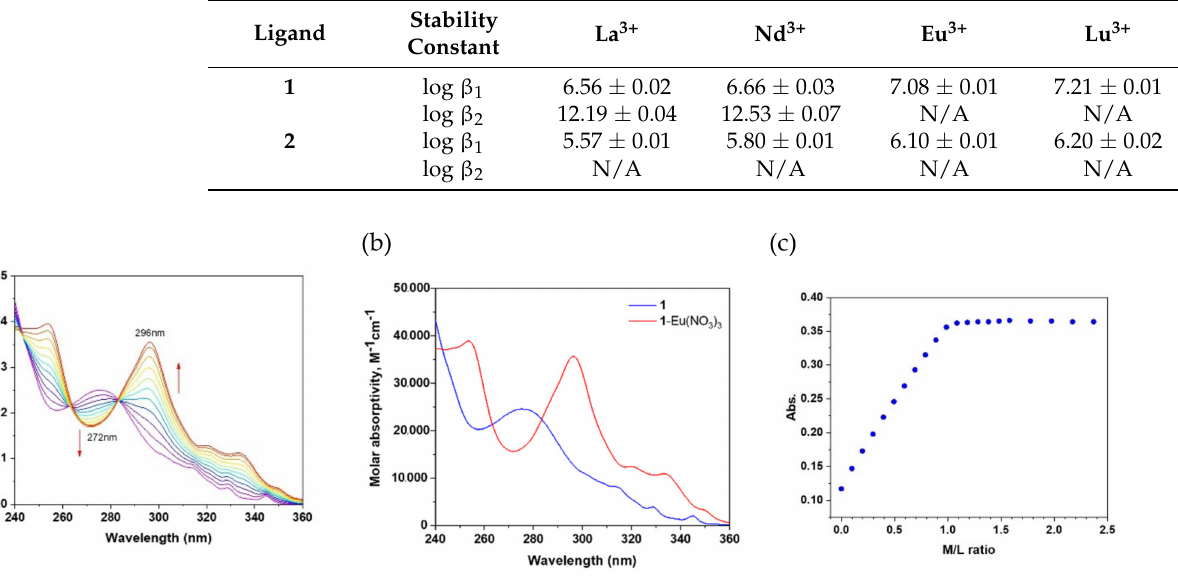
Table 6. Stability constants (log β ) of complexes of 1 and 2 with nitrates of La, Nd, Eu and Lu.